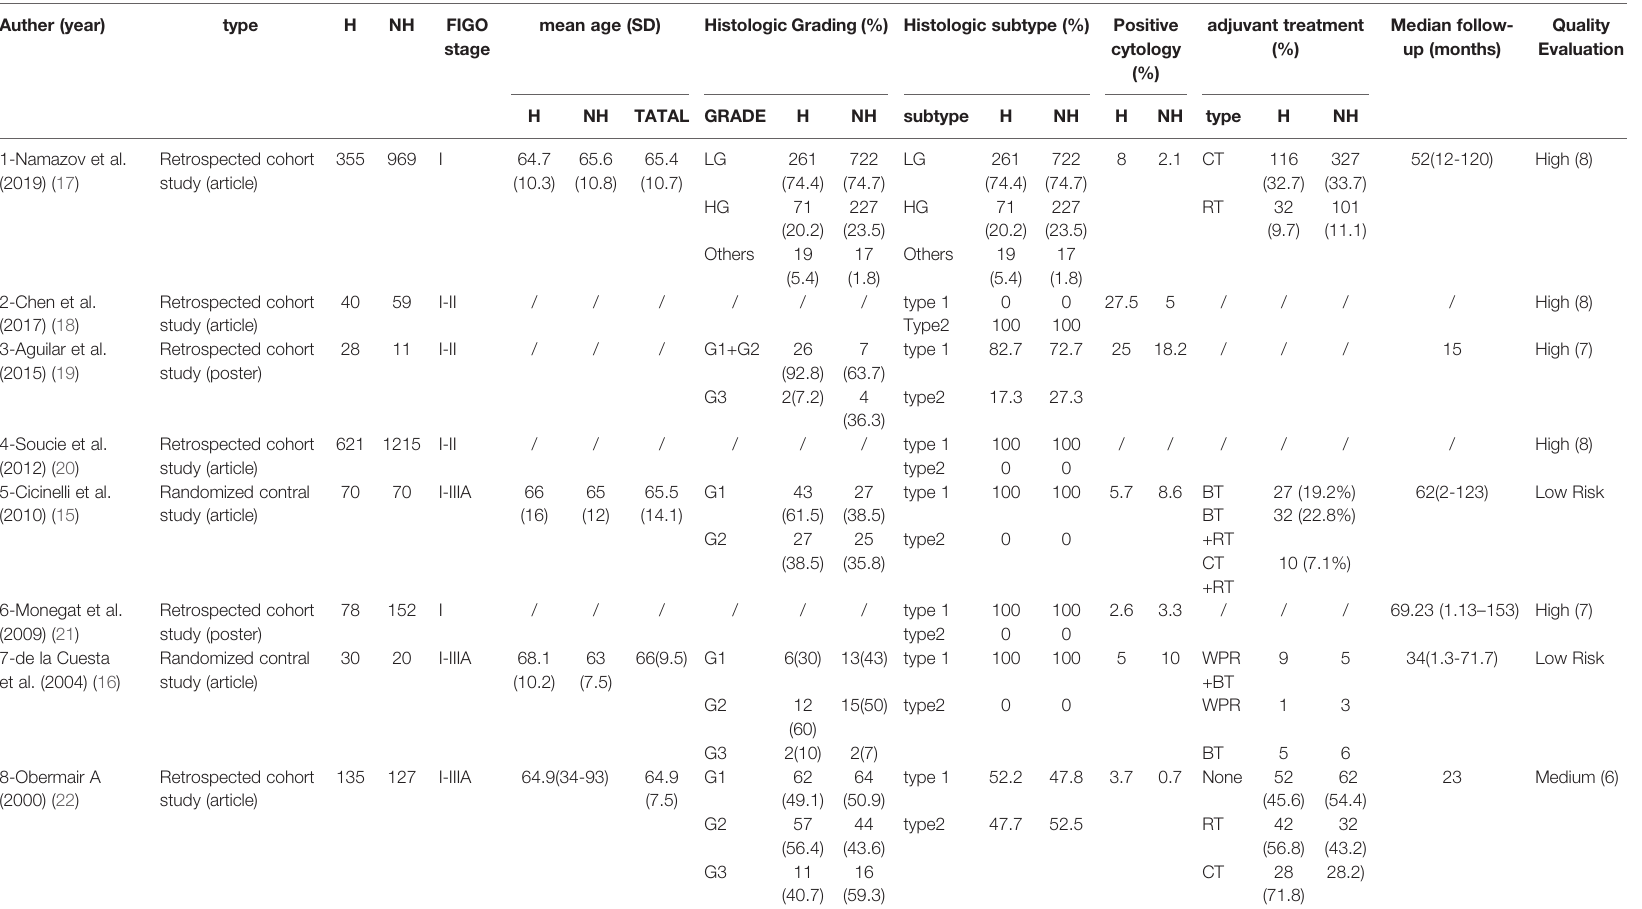
TABLE 1 | Characteristics of Included